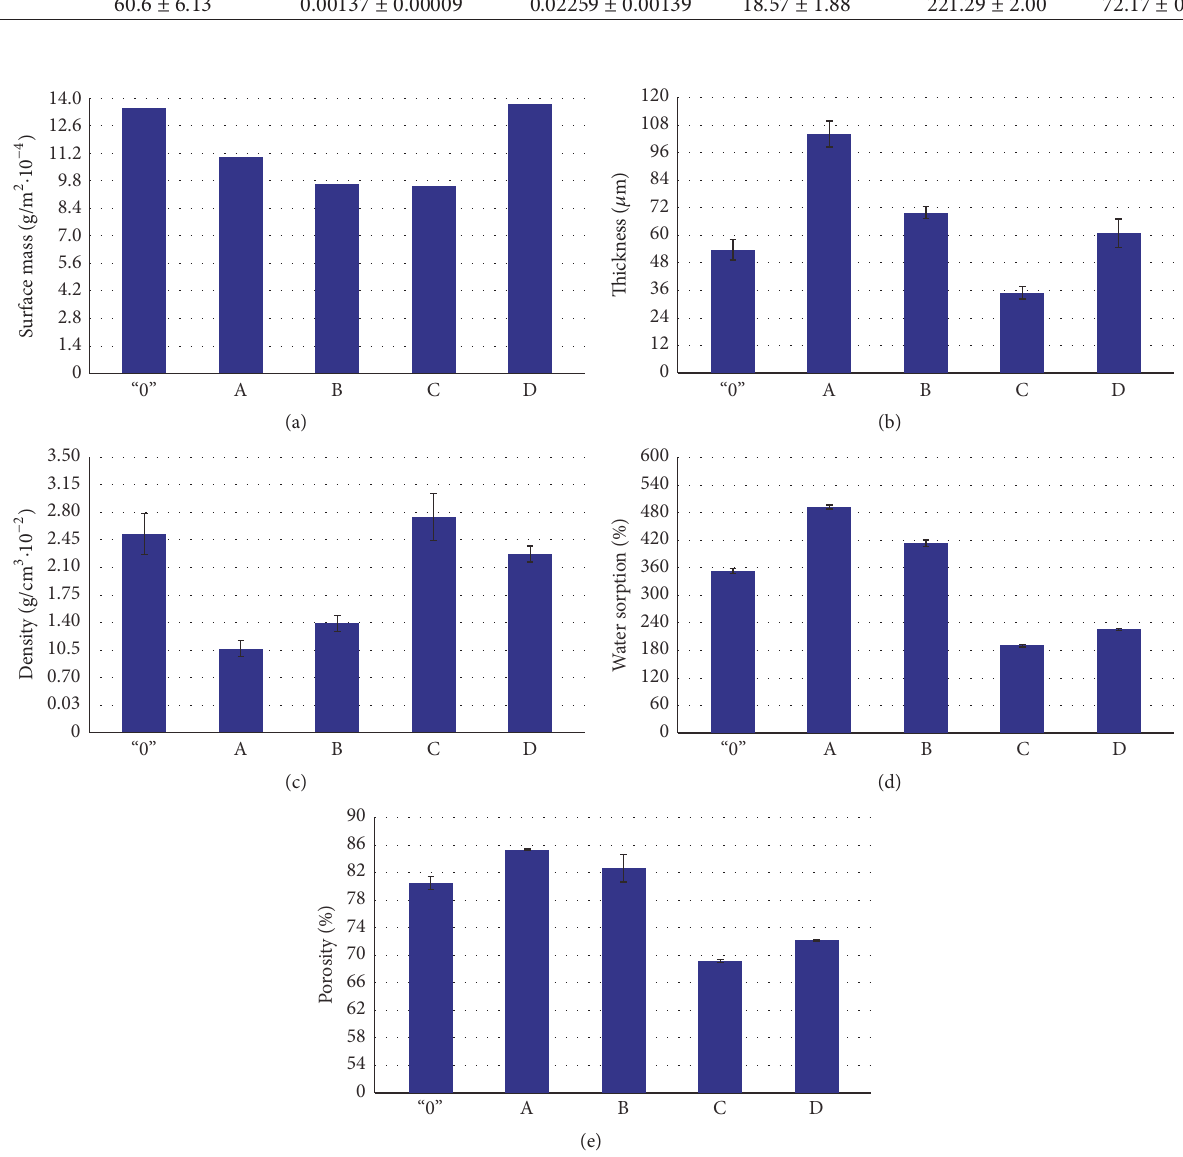
Figure 3: The effect of membrane forming on the thickness, mass per unit area, density, water sorption, and